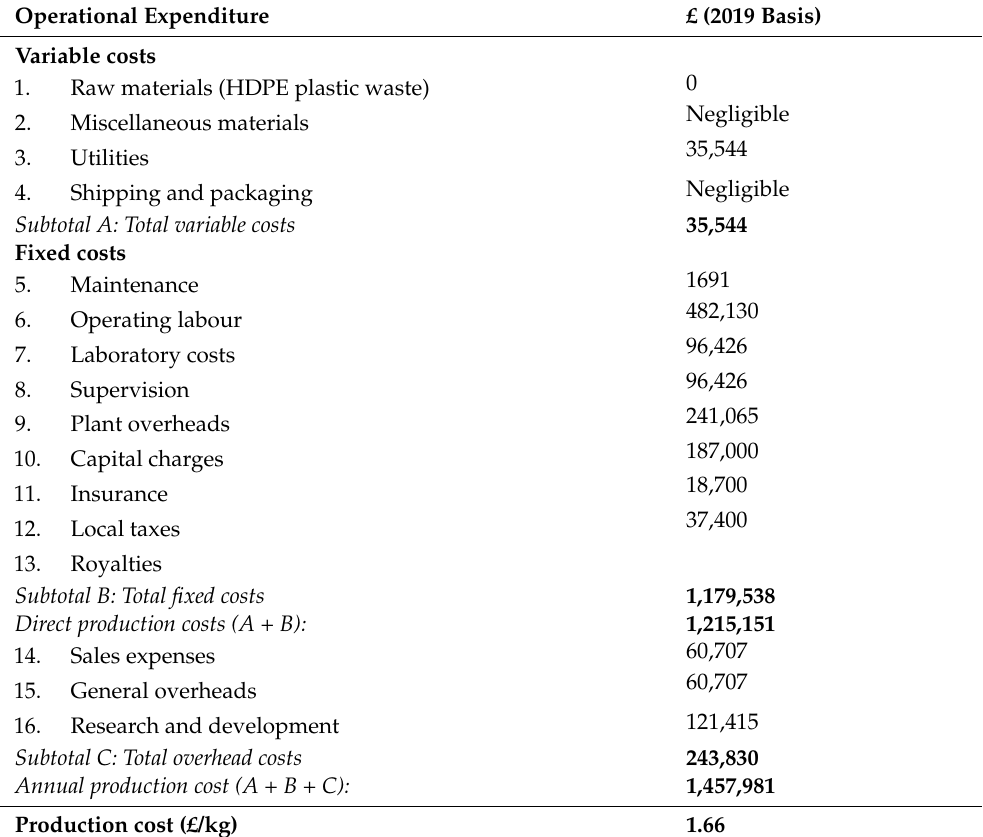
Table 4. Operational expenditure from HYSYS simulation for the conversion of HDPE to fuel via